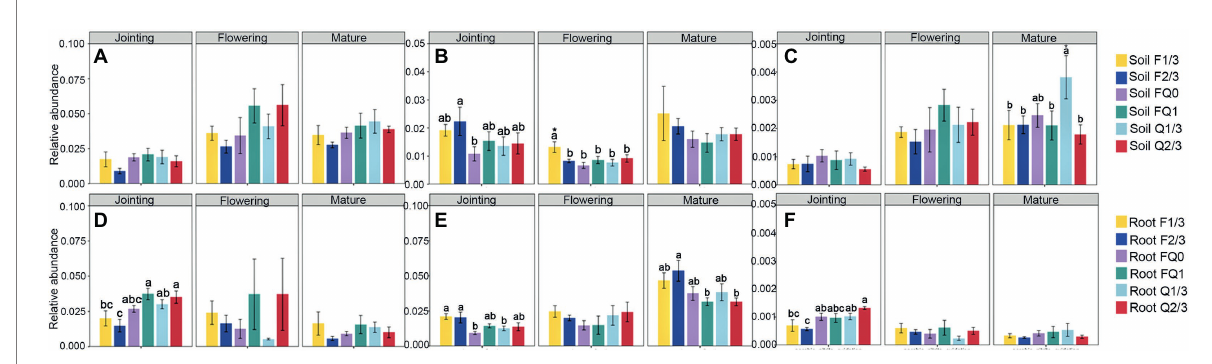
FIGURE 2 The relative abundance of functional guilds related to (A) nitrification (B) nitrogen fixation, and (C) anaerobic nitrate oxidation in rhizosphere soil; and the relative abundance of functional guilds related to (D) nitrification (E) nitrogen fixation and (F) anaerobic nitrate oxidation in roots. Different letters indicate significant differences at p < 0.05. * indicates significant differences at p < 0.01. No letter indicates significant differences at p > 0.05 between all groups. FQ0: control with no maize stover return; Q1/3: 1/3 stover mulch applied every year; Q2/3: 2/3 stover mulch applied every